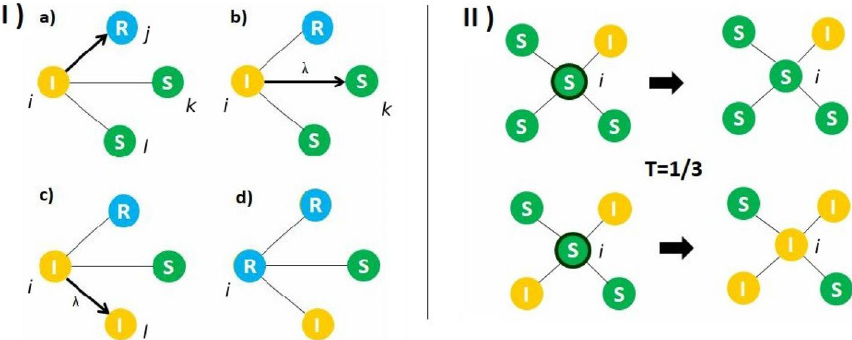
Figure 2. (I) Simple contagion: each informed node (I) tries to inform all of its susceptible (S) neighbors before becoming recovered (R). ( a ) Node i tries to inform node j , but fails because j is in a recovered state. ( b ) Then, node i tries to inform node k , with a probability of success (cid:31) , failing in this case. ( c ) Finally, node i succeeds in informing node l . ( d ) After having tried to inform all of its neighbors, node i becomes recovered (R). (II) Complex Contagion (with threshold T = 1 3 ). Upper panels: node i has only a fraction 1 4 of informed neighbors, so it remains susceptible. Lower panels: node i has a fraction 1 2 of informed nodes, so the threshold is surpassed and therefore it becomes